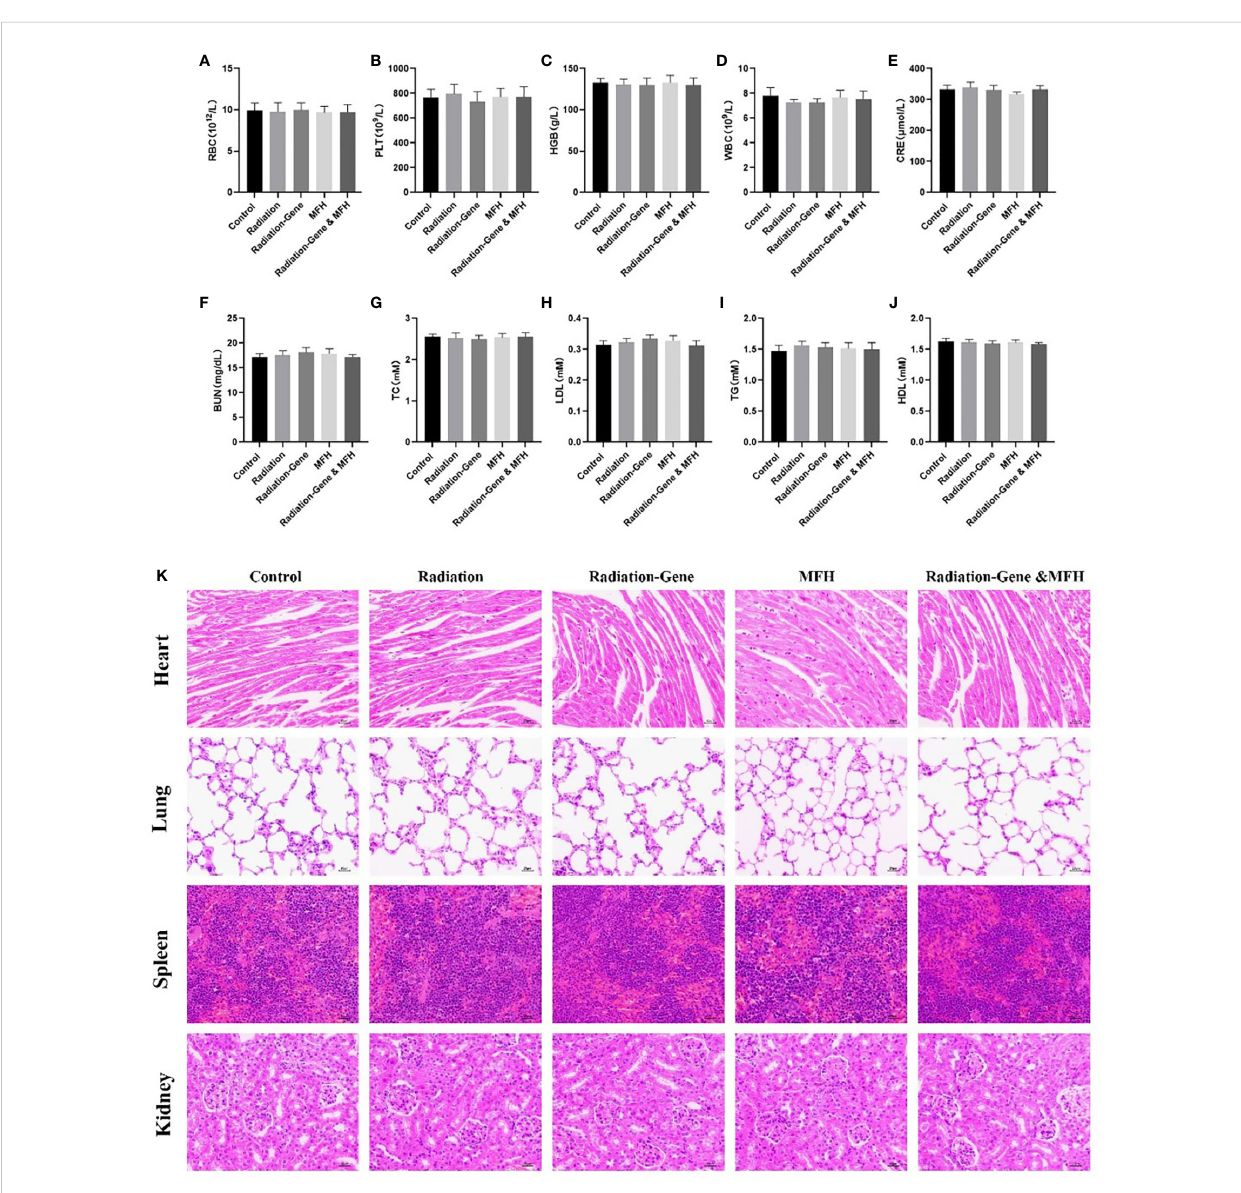
FIGURE 13 Long term safety of nanoparticle after treatment with different formulations. (A – J) RBC, PLT, HGB, WBC, CRE, BUN, TC, LDL, TG, HDL. (K) Histological evaluation of organs (heart, lung, spleen and kidney) from HCC mice two months post